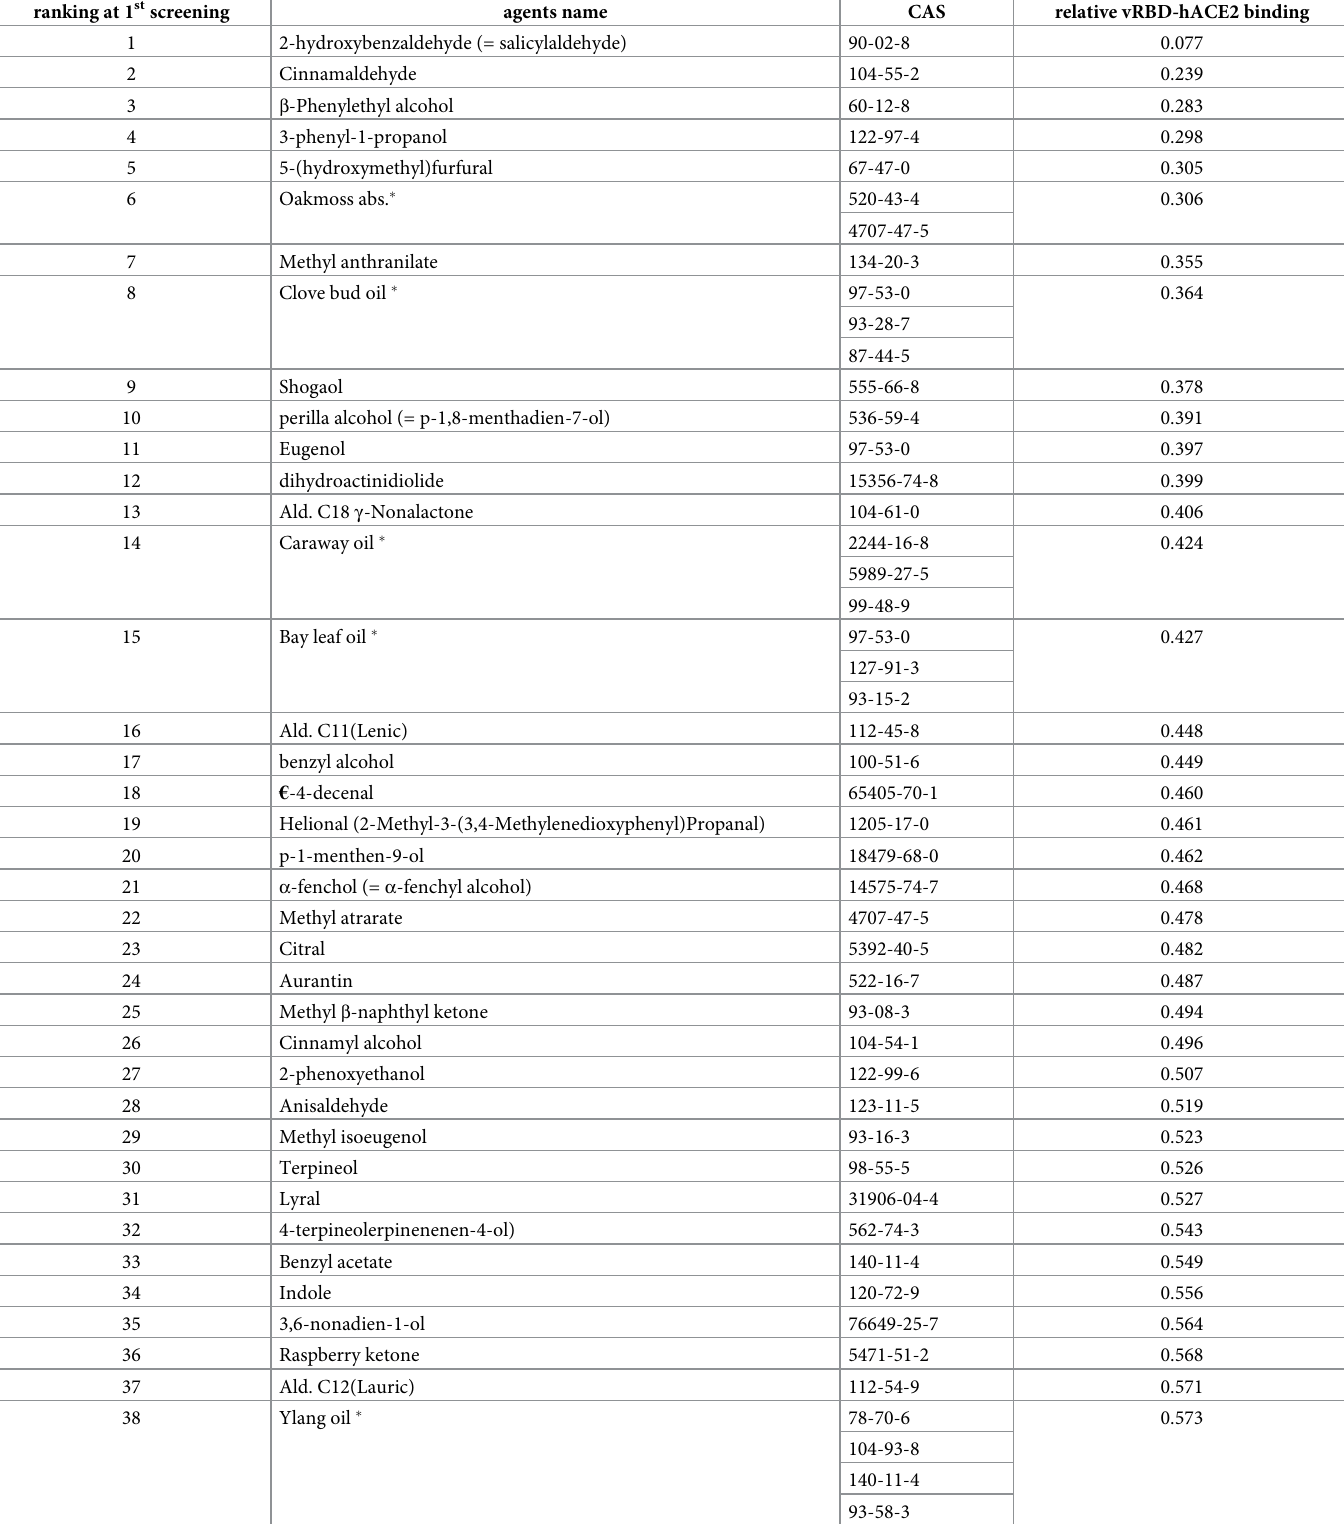
Table 1. Ranking of flavor/fragrance compositions in the first screening. ranking at 1 st